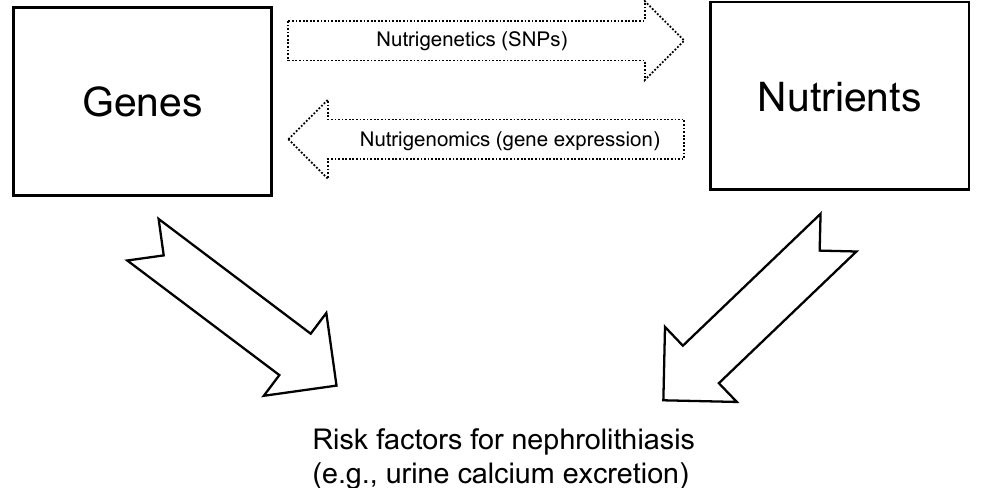
Figure 1. Schematic representation of the link between nutrients, genes, and risk factors for nephrolithiasis.